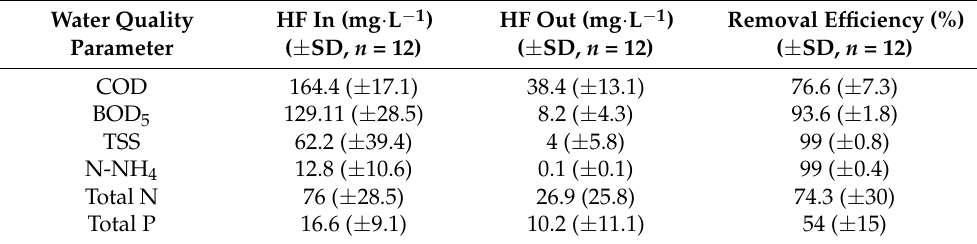
Table 1. Average concentrations and removal efficiencies with standard deviation ( ± SD) of the physicochemical parameters detected at the inflow (in) and outflow (out) of the HF-TW during the experimental period (January–December